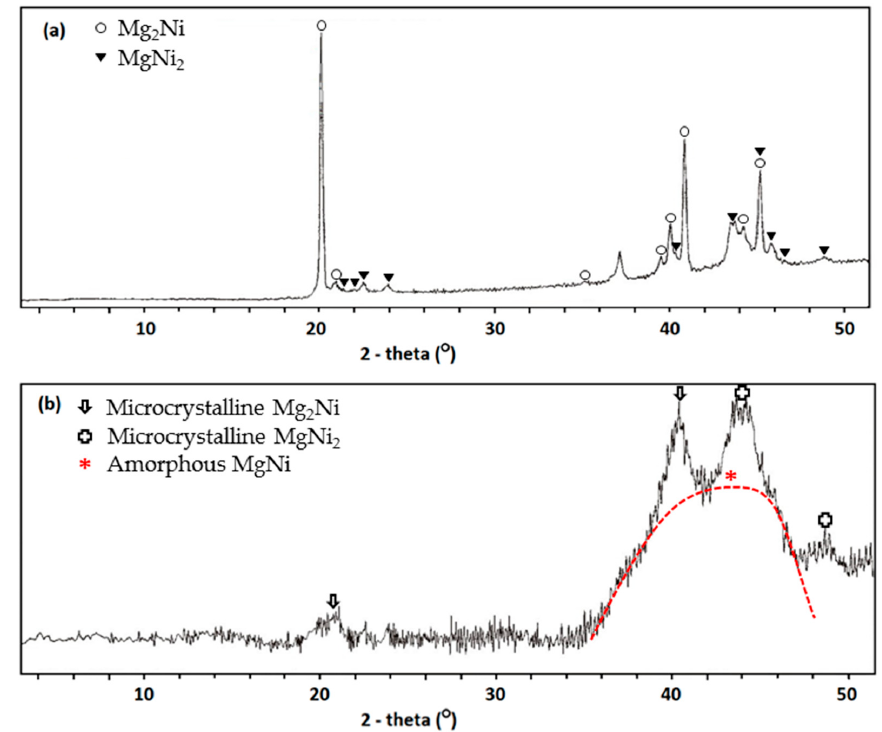
Figure 5. XRD patterns from MS AR3 ribbon samples ( a ) before and ( b ) after MA. With MA, the microstructure changes from polycrystalline Mg 2 Ni and MgNi 2 phases to amorphous MgNi and microcrystalline Mg 2 Ni and MgNi 2 phases.